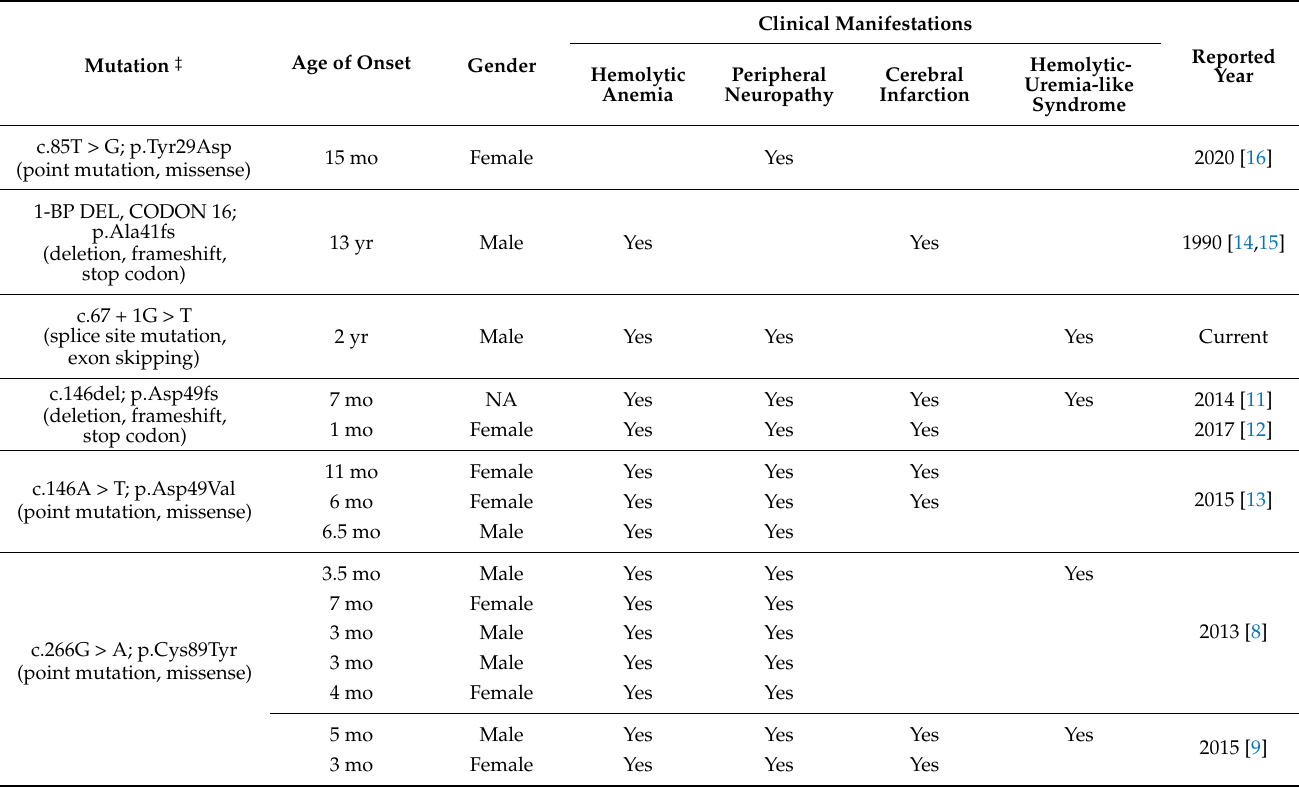
Table 1. Literature review of the published variants in the CD59 gene. Variants are listed in the order of nucleotide